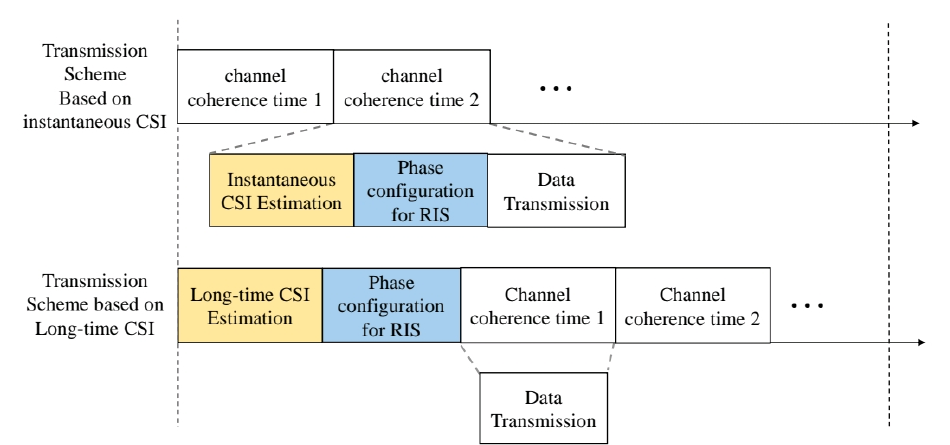
Figure 2. Transmission